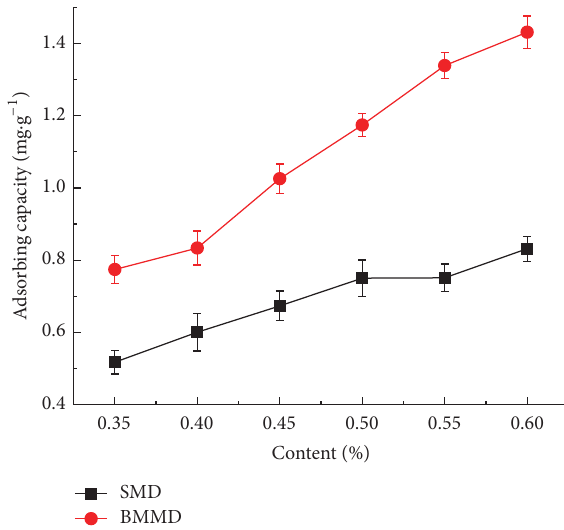
Figure 3: Effect of SMD and BMMD content on the adsorption capacity.